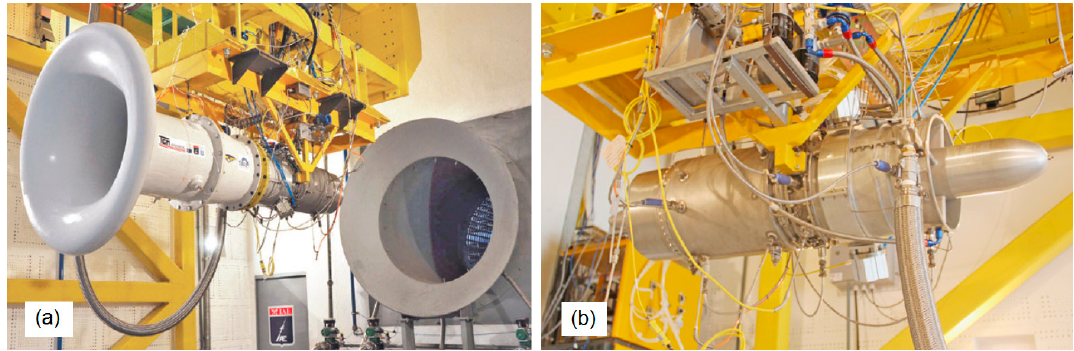
Figure 1. Illustration of the aeronautical gas turbine studied in this work on test rig: ( a ) Perspective view including inlet and exhaustion ducts; ( b ) Side view.